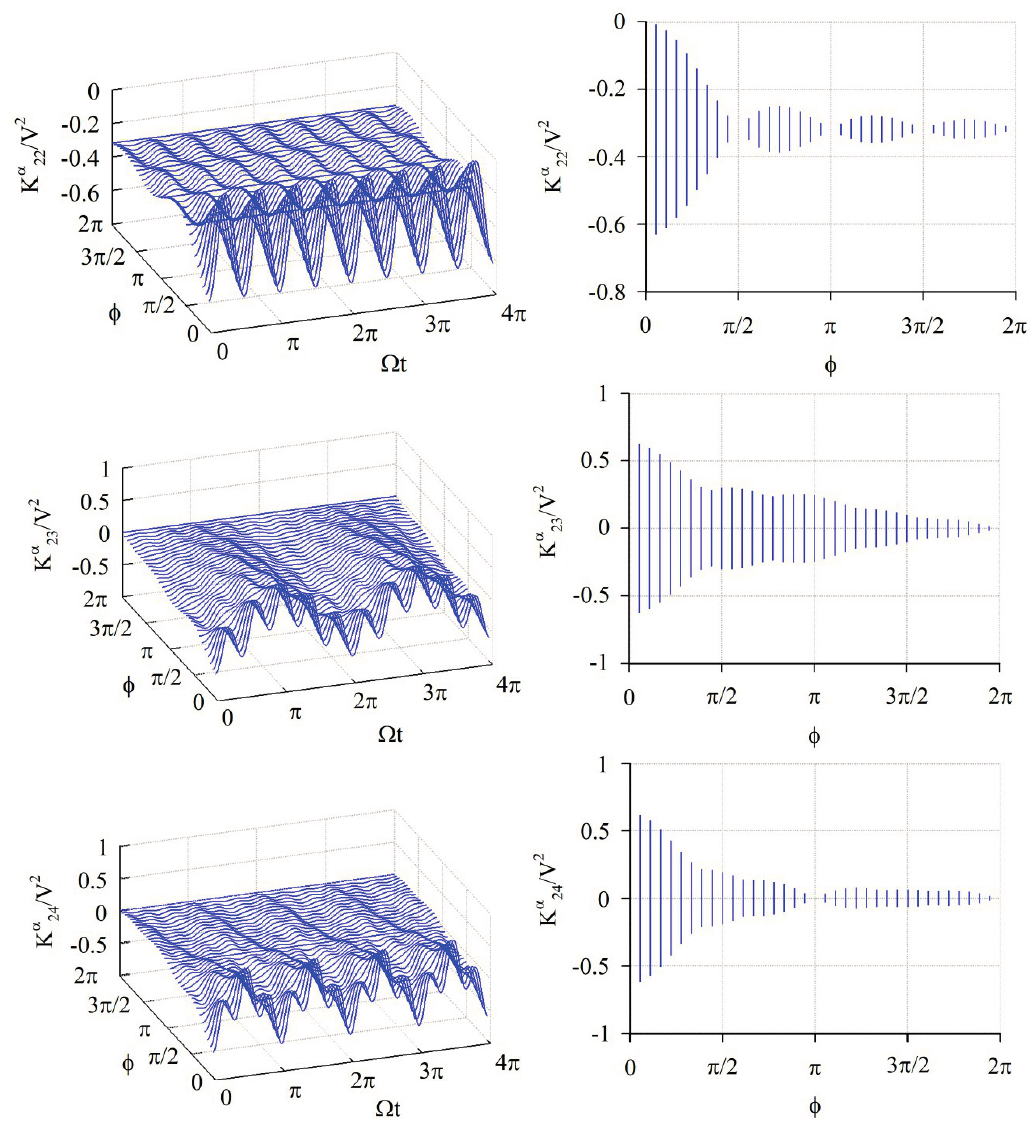
Figure 3. The numerical results of some feature elements ( 2 of the α -partition of stiffness matrix. The graphs at the right-hand side are the projections of the graphs at the left-hand side on the plane containing ϕ -axis and K